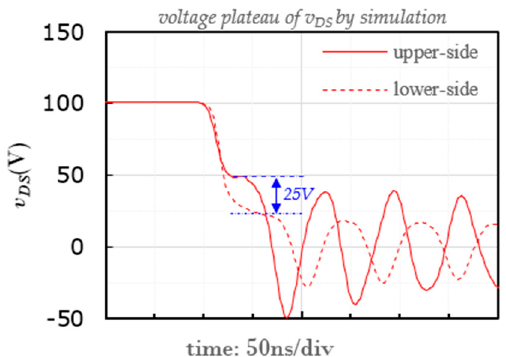
Figure 18. The simulation results about difference of drain-source voltage plateau between upper-side and lower-side by LTspice.